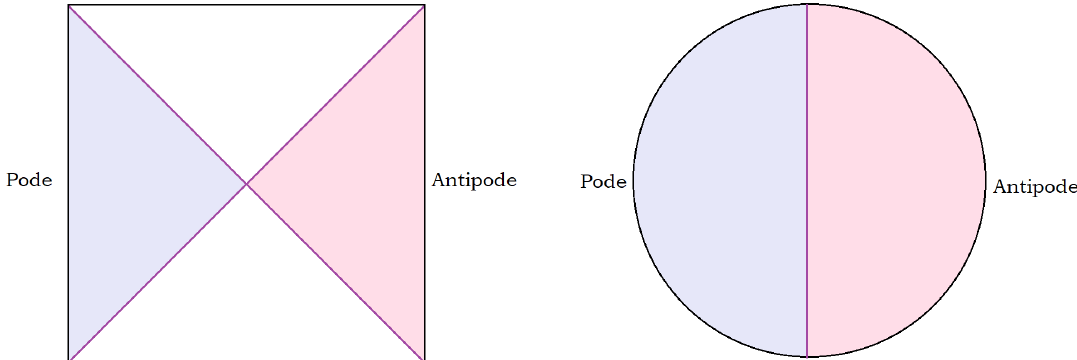
Figure 1 . The left panel shows the Penrose diagram for de Sitter space with the pode and antipode static patches shown shaded. The right panel shows a time-symmetric spatial slice which forms a ( D − 1) -sphere. The horizons in both panels are colored purple. In the right panel the horizon is the bifurcate horizon which forms a ( D − 2)